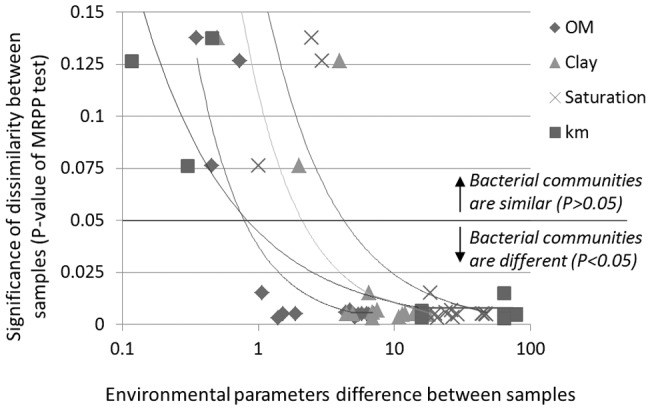
Higher differences in environmental parameters cause higher differences in community structure.Each point in the graph represents a comparison between two samples: the X axis depicts the difference between the two samples with respect to the following environmental parameters in soils: OM – organic matter; Clay – clay percentage; Saturation – water saturation; km – geographic distance between the samples in kilometers; the Y axis is the significance of the dissimilarity (MRPP tests' P-value) between bacterial communities from the two samples. Trend lines are R2>0.8 for all environmental parameters. Values under the ‘0.05 line’ signify two bacterial communities that are significantly different (P<0.05).